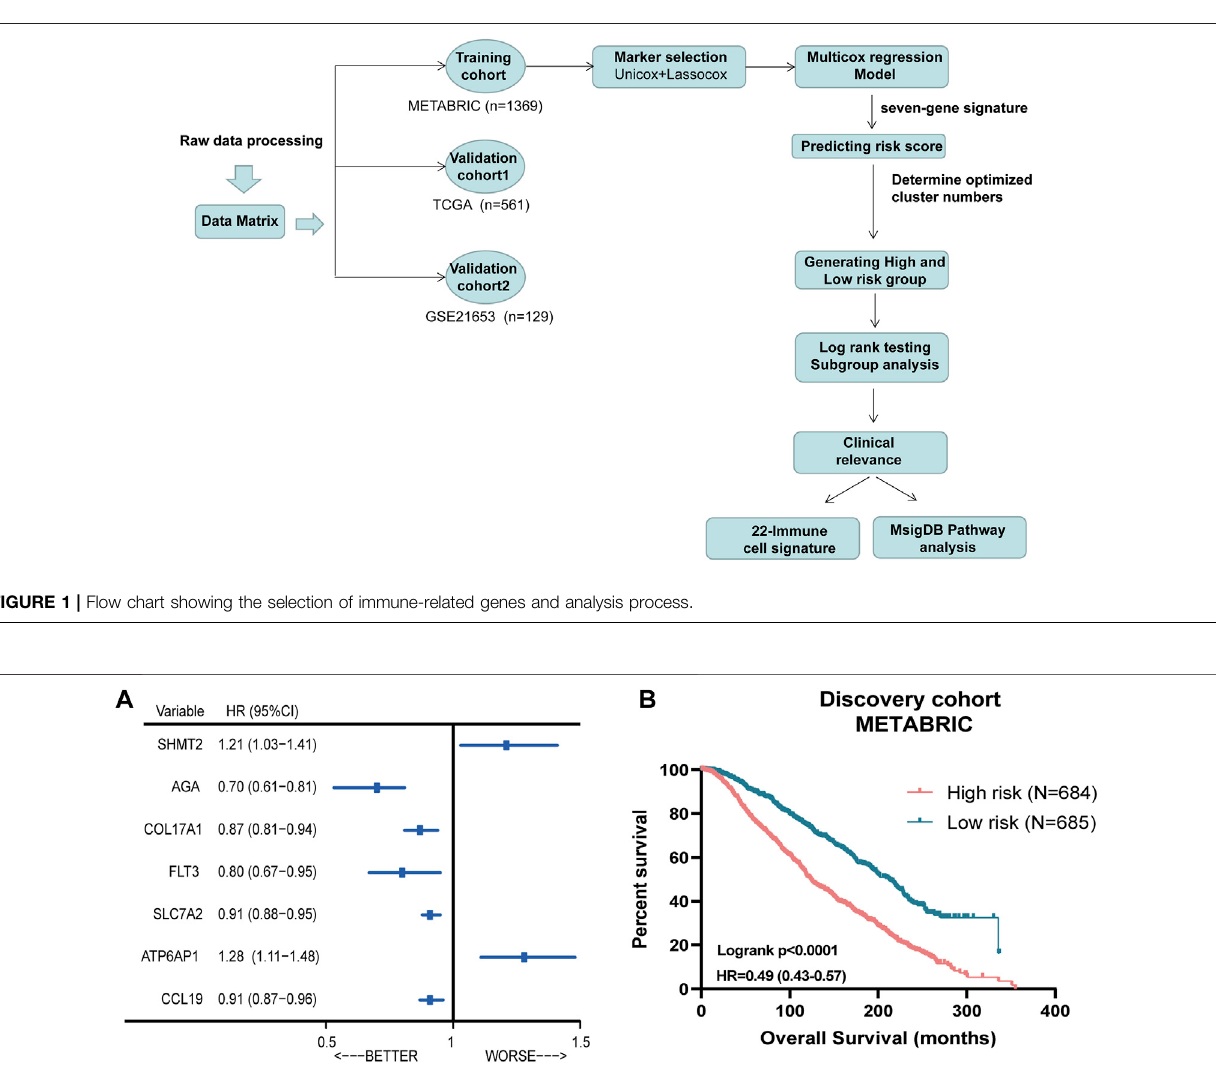
Frontiers in Pharmacology |